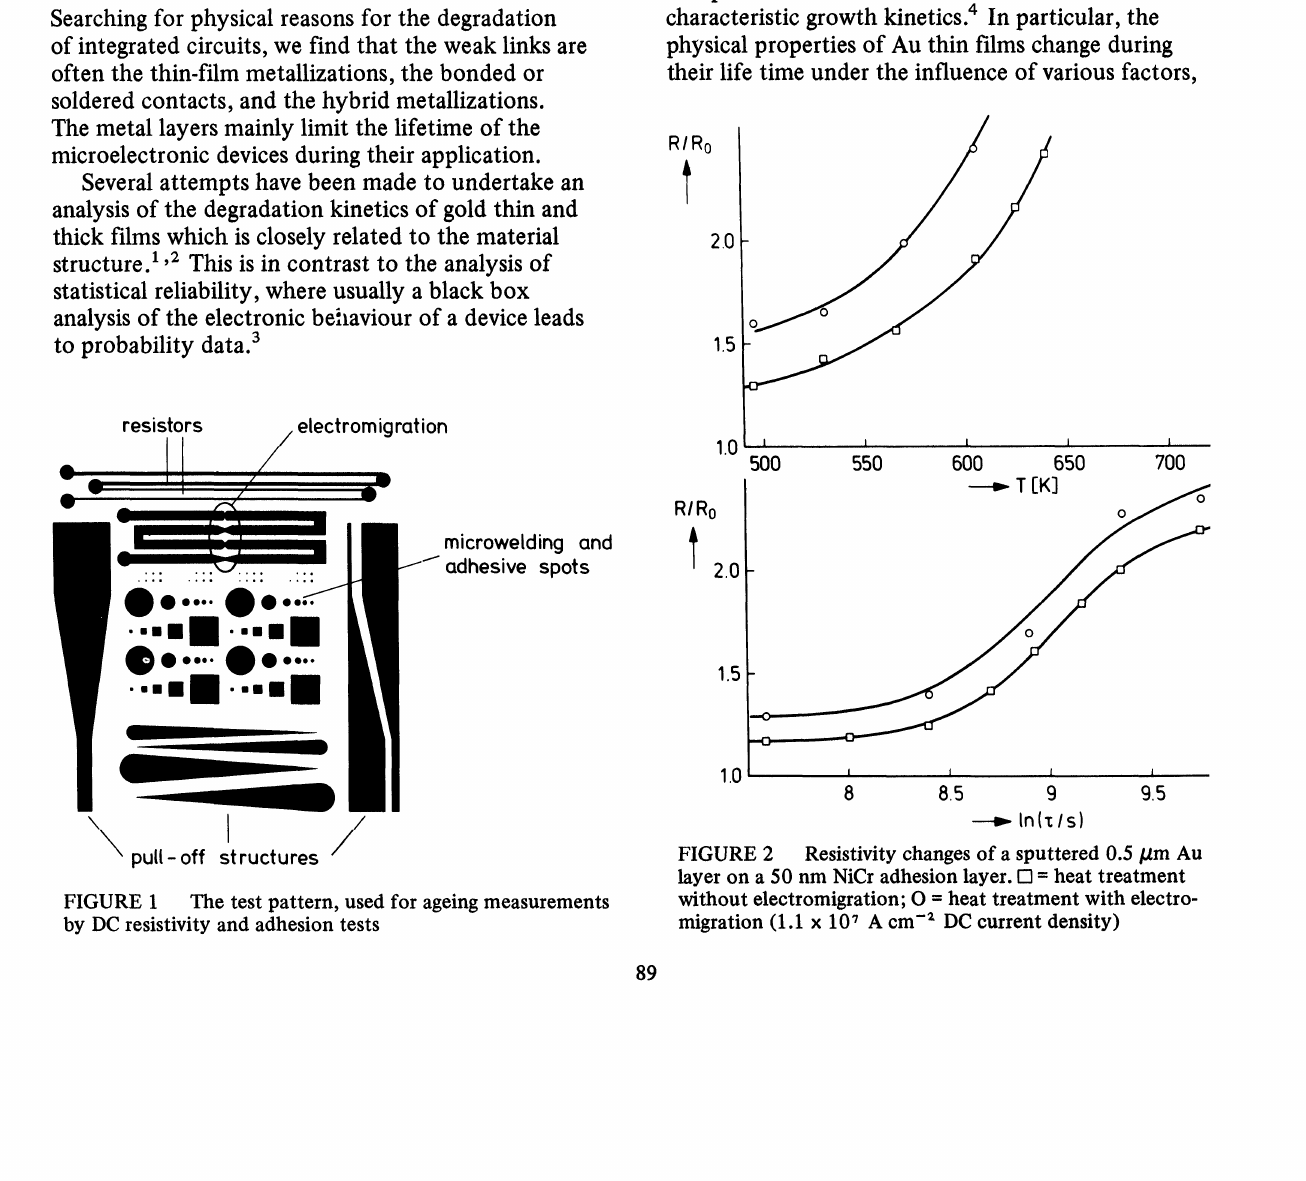
- Resistivity changes of a sputtered 0.5/am Au layer on a 50 nm NiCr adhesion layer. [] heat treatment without electromigration; O heat treatment with electro- DC current migration (1.1 x 107 A cm 89